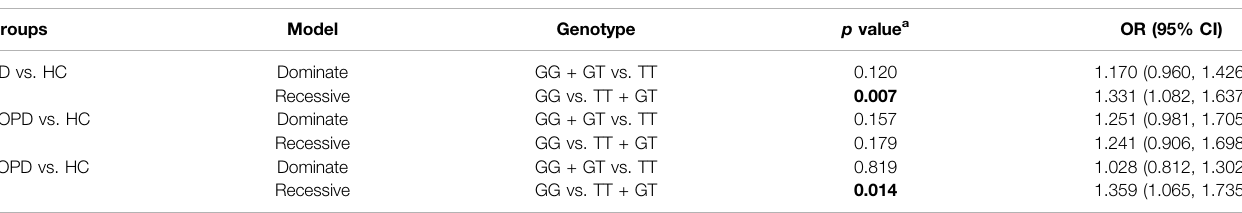
TABLE 4 | Analysis of genetic models for WNT3 rs2074404 on risk for PD. Groups Model PD vs.